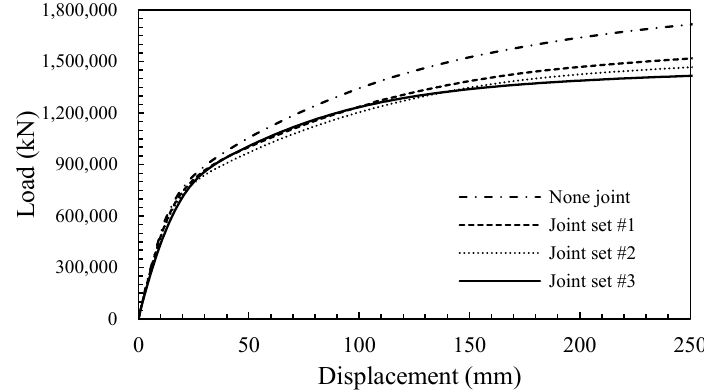
Figure 10. Load-horizontal displacement curve with joint orientation.